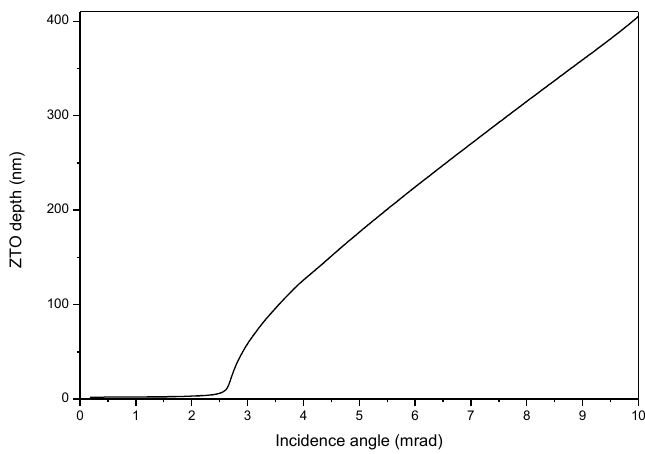
Figure A1. Calculated depth penetration curve for the 5% doped TZO film composition considered in this work.